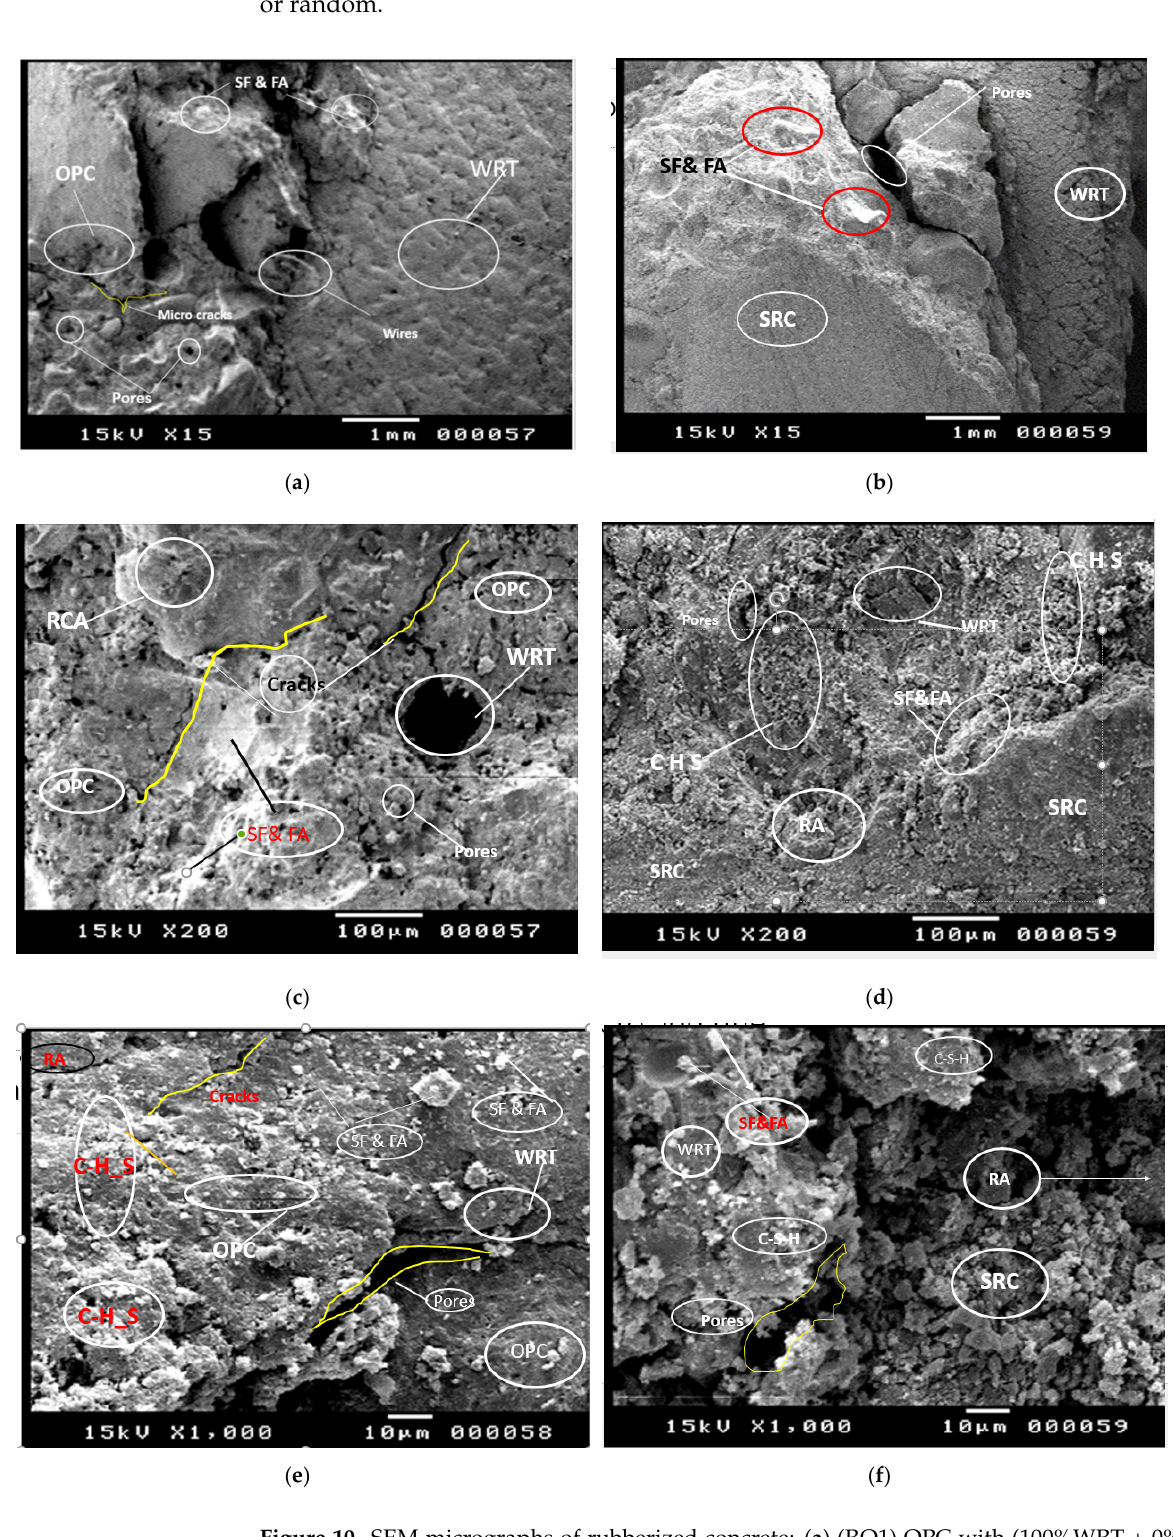
Figure 10. SEM micrographs of rubberized concrete: ( a ) (RO1) OPC with (100%WRT + 0%RCA); ( b ) (RS4) SRC with (100%WRT + 0%RCA); ( c ) (RO2) OPC with (75%WRT + 25%RCA); ( d ) (RS5) SRC with (75%WRT + 25%RCA); ( e ) (RO3) OPC with (50%WRT + 50%RA); ( f ) (RS6) SRC with (50%WRT +